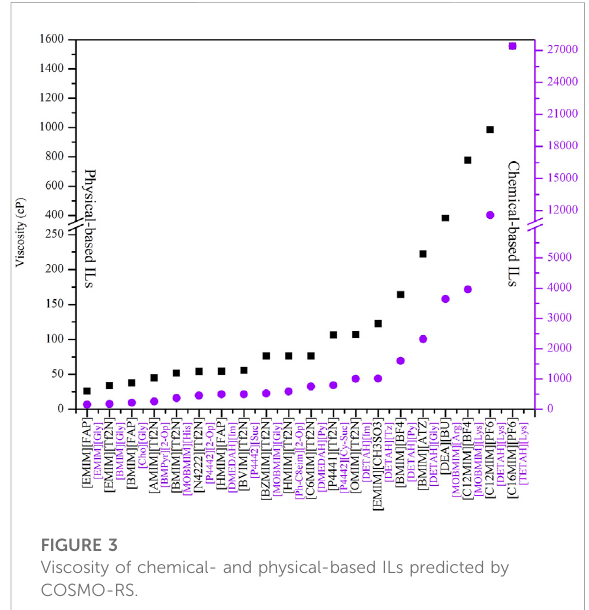
FIGURE 3 Viscosity of chemical- and physical-based ILs predicted by COSMO-RS.